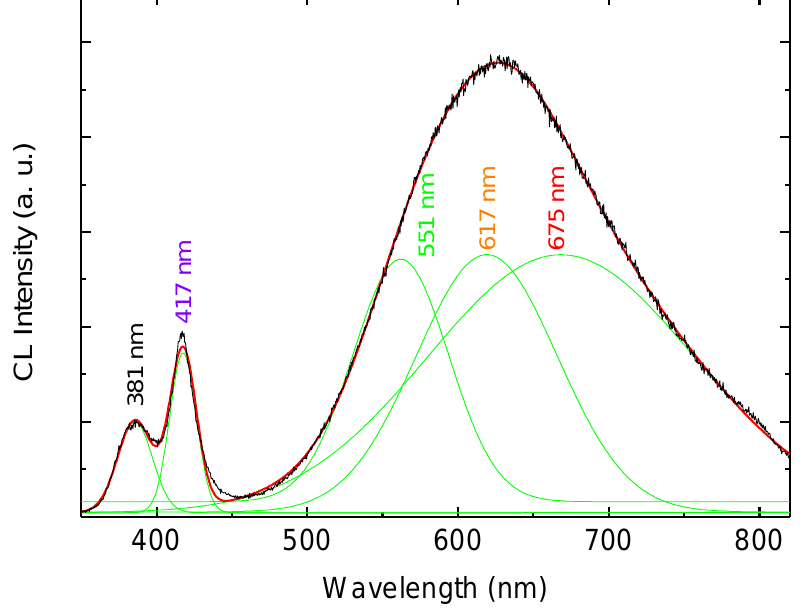
Figure 5. Room temperature CL spectrum of the hybrid LED after the Gaussian